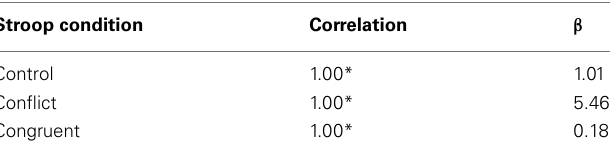
Table 2 | Fit of Piéron’s law against simulation data single stage model with unlocked inputs.